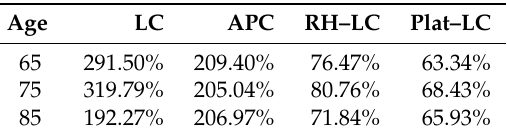
Table 12. Relative amplitude of prediction intervals for male Maltese death rates in 2046 with different mortality